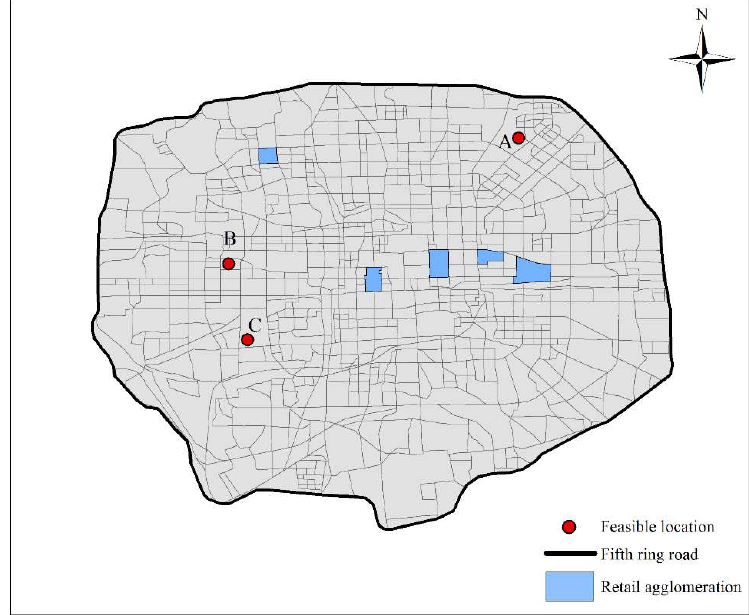
Figure 3. Feasible areas for a new retail agglomeration in the study area.